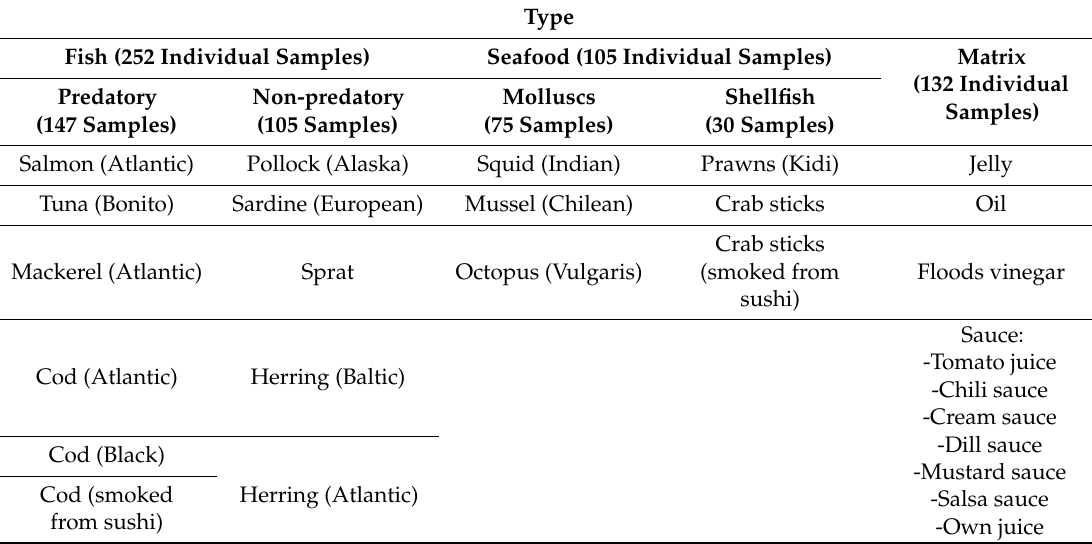
Table 7. Characteristics of tested samples in relation to their